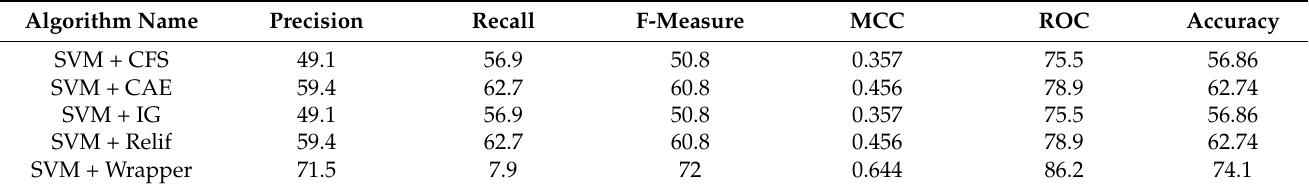
Table 15. Comparison among feature extraction algorithms using SVM classifier to predict the total infected cases.